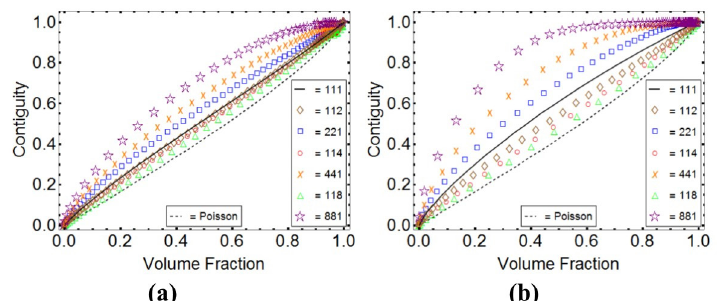
Figure 8. Contiguity of oblate and prolate ellipsoids as a function of volume fraction transformed. The curves show the effect of the ellipsoid shape and the number of nuclei per plane on the contiguity. The dashed line is the theoretical line for the contiguity of spherical regions nucleated in space according to a homogeneous Poisson point process. The solid line is the simulated contiguity of spheres nucleated on parallel planes. The symbols correspond to computer-simulated results. Figure 8a depicts the contiguity of ellipsoids nucleated on 20 random parallel planes with 10 nuclei per each plane. Figure 8b depicts the contiguity of ellipsoids nucleated on 20 random parallel planes with 80 nuclei per each